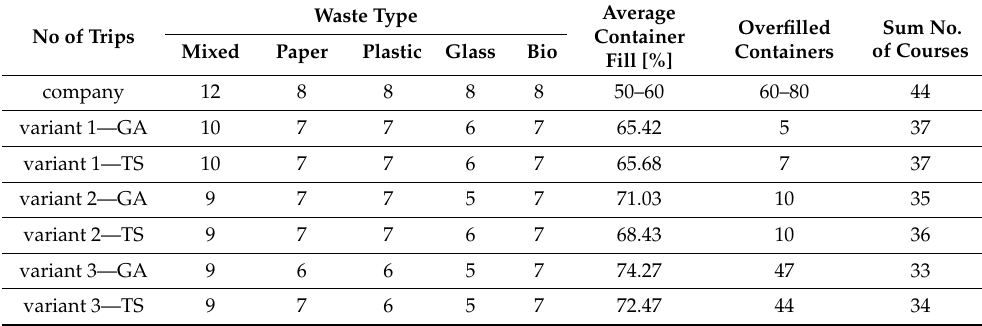
Table 3. Variant 1–3